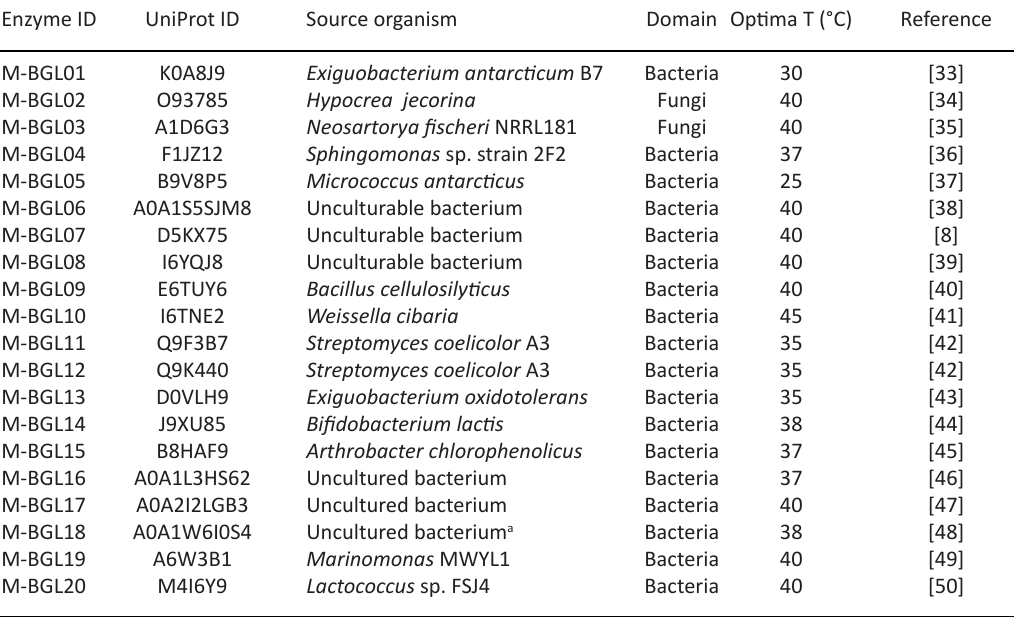
Table 1. Mesophilic GH1 β -Glucosidase with UniProt ID and reported optimal temperature Enzyme